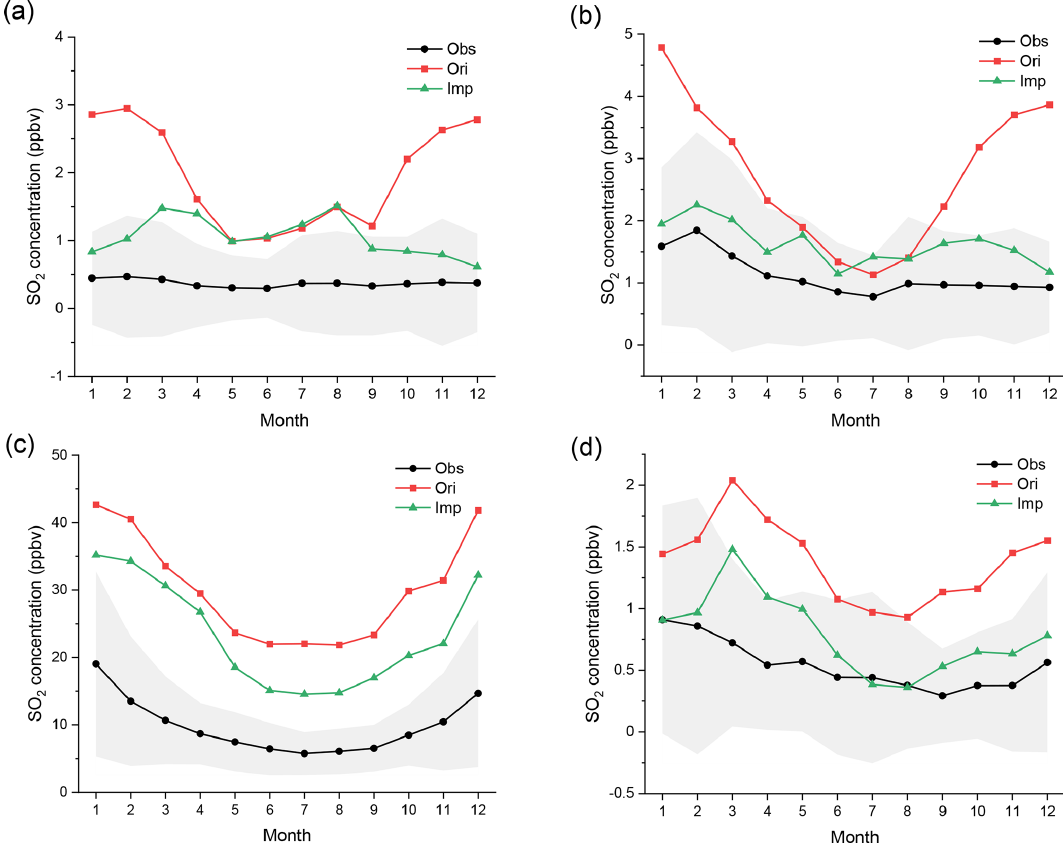
Figure 4. Regional monthly average mixing ratios (ppbv) of SO 2 in EU, USA, CN, and JK in 2015. The black, red, and green lines represent the observed, original-simulated, and improved-simulated mixing ratios, respectively. The gray areas represent the standard deviation of observed mixing ratios. The corresponding monitoring networks are (a) EMEP, (b) EPA, (c) CNEMC, and (d)